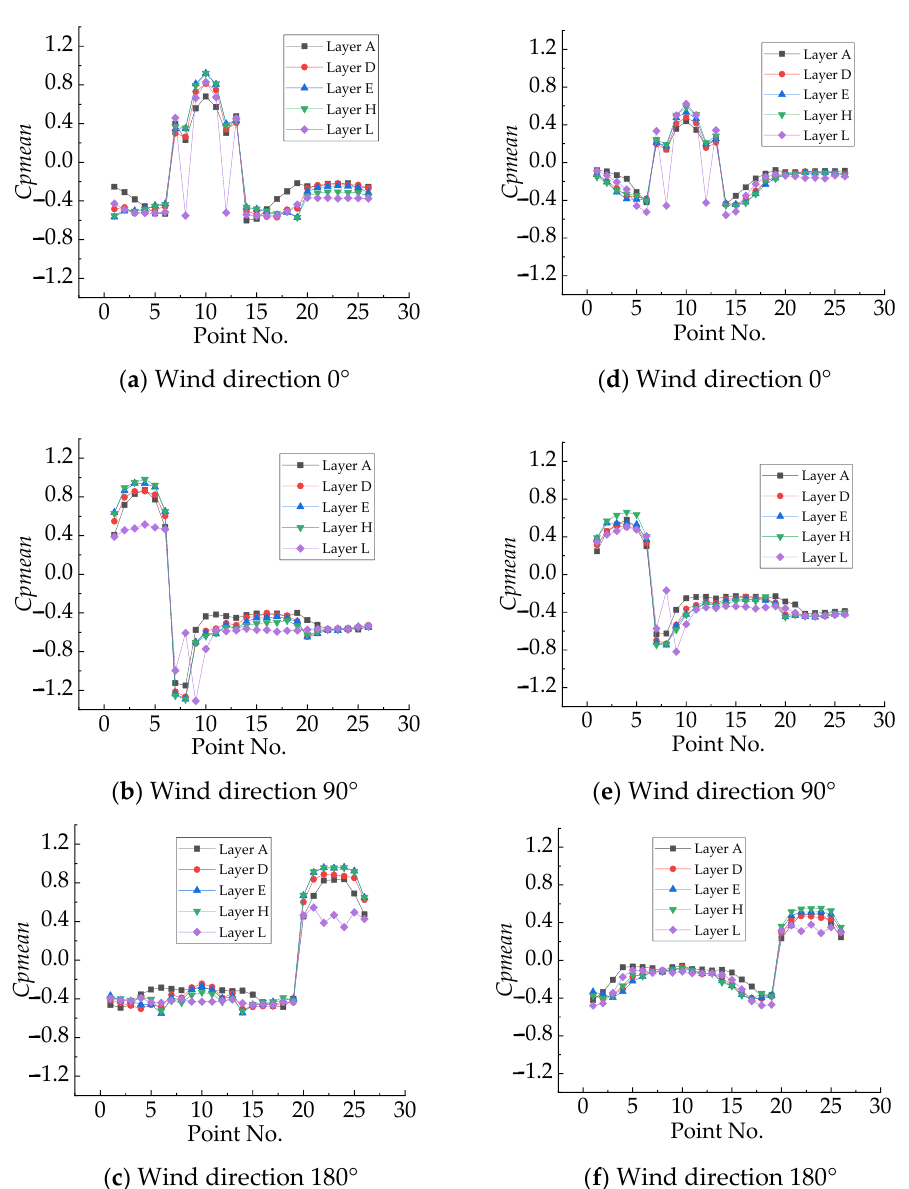
Figure 6. Variations in average wind pressure coefficient Cpmean for building surfaces with changing wind directions: ( a – c ) uniform flow (UF); ( d – f ) boundary layer (BL).